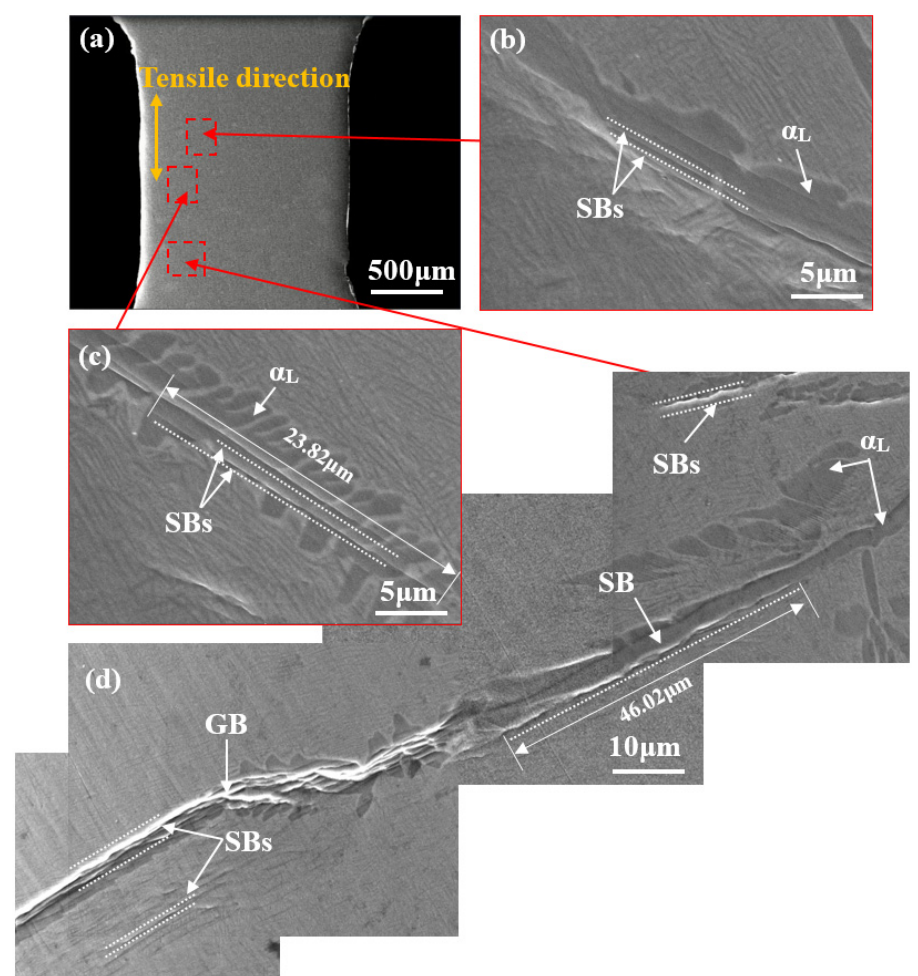
Figure 9. ( a ) In situ SEM images of lamellar microstructure at position A’; ( b , c ) magnified image showing several SBs in an α L phase or at its interface; ( d ) magnified image showing plentiful SBs in a long coarse α L phase at a GB at an angle of about 45° to the tensile direction.